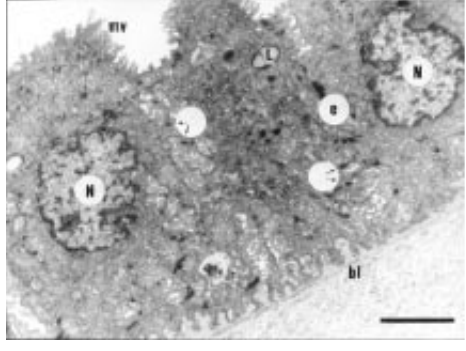
Figure 2 - Transmission electron micrograph of new vaginal epi- thelium 60 days after application of amnion graft. The cells are characteristic of squamous epi- thelium with oval nuclei (N), abundant cytoplasm (c) with nu- merous desmosomes (arrow heads) and tonofilaments. Lead citrate and uranyl acetate stain- ing (bar = 1 µm).